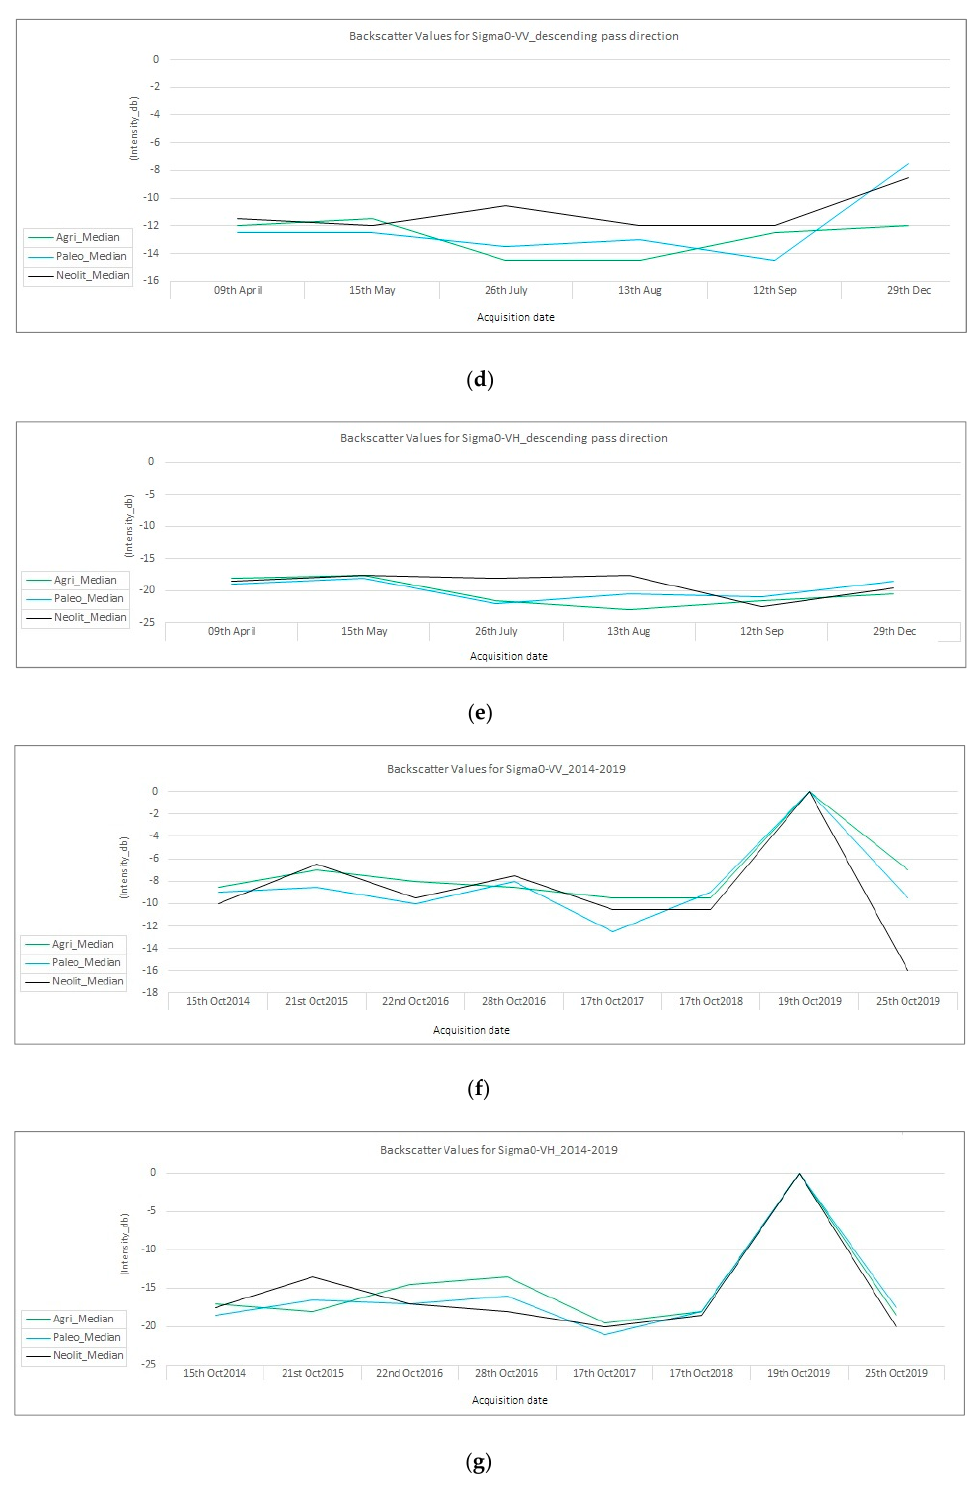
Figure 13. The graphs of the backscatter values for the Sentinel 1 radar images in 2019 from March to December and starting from 2014 to 2019 in October: ( a ) the composite image from the stack VH polarization in March, June, and December months; ( b ) graph for the polarization Sigma0-VV_ ascending pass direction in 2019; ( c ) graph for the polarization Sigma0-VH_ascending pass direction in 2019; ( d ) graph for the polarization Sigma0-VV_ descending pass direction in 2019; ( e ) graph for the polarization Sigma0-VH_ descending pass direction in 2019; ( f ) graph for the polarization Sigma0-VV between 2014 and 2019 in October; ( g ) graph for the polarization Sigma0-VH between 2014 and 2019 in October. In the same context, SAR data for 2014, 2015, 2016, 2017, 2019, and 2019 were analyzed along with the VV/VH polarizations for the month of October (see Table in Appendix and Figure 13f,g), which is considered the best time for extracting some buried shapes (Figure 13a,e,f). As a whole, the analysis performed herein suggested that: